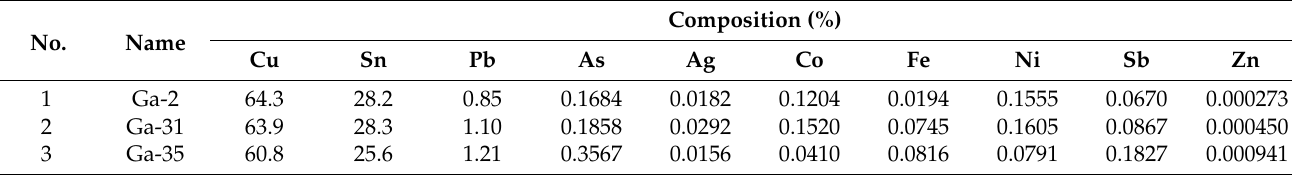
Table 4. Chemical composition of bronze mirrors obtained from the Sinpung site using inductively coupled plasma atomic emission spectroscopy (ICP-AES) analysis.